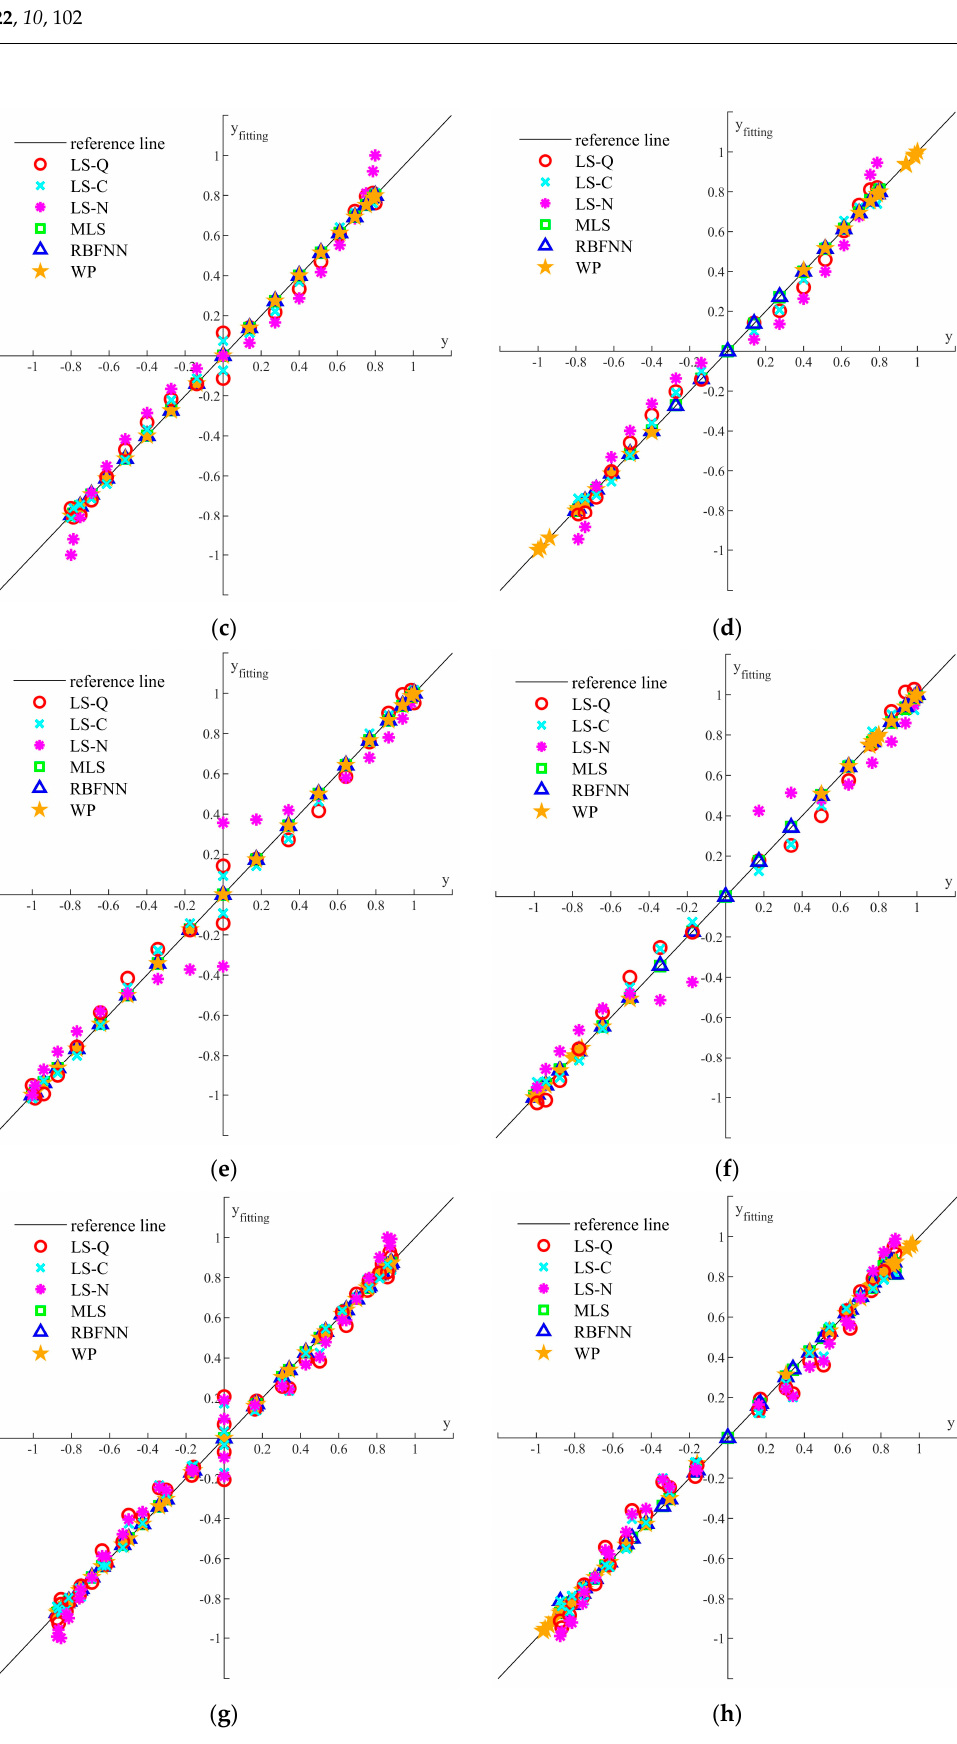
Figure 4. Accuracy comparison of fitting results for ( a ) TD1 in Case 1, ( b ) TD1 in Case 2, ( c ) TD2 in Case 1, ( d ) TD2 in Case 2, ( e ) TD3 in Case 1, ( f ) TD3 in Case 2, ( g ) TD4 in Case 1, and ( h ) TD4 in Case